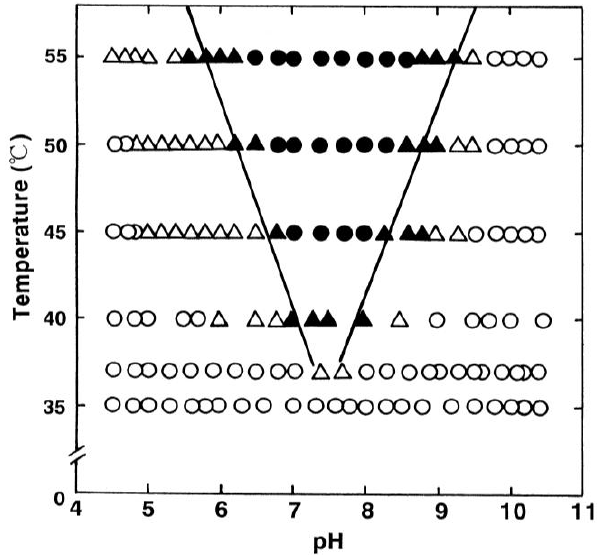
Figure 2. pH-temperature diagram of hemichrome formation for human HbO from Sugawara et al. [13]. The symbols represent:  - hemichrome formation noticeable at initial stage during the course of autoxidation;  - at intermediate stage;  - at final stage;  - autoxidation reaction proceeded with no hemichrome formation during the entire